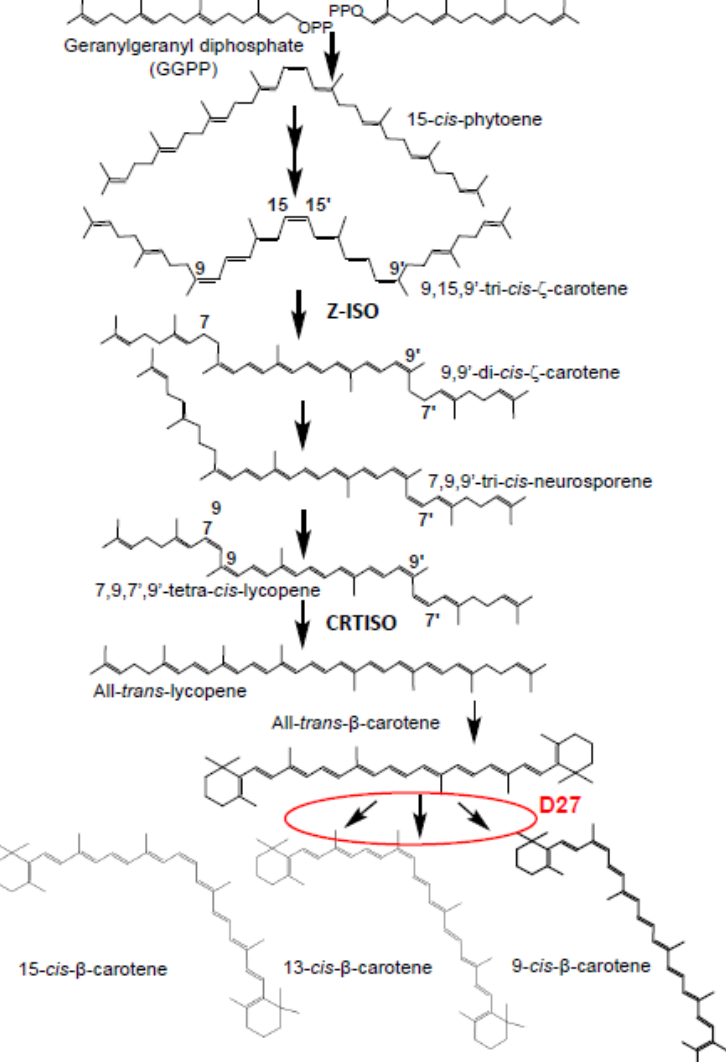
Figure 1. Carotenoid biosynthetic pathway from geranylgeranyl diphosphate to β -carotene. The steps in which carotenoid isomerases are known to be involved are indicated by the name of the corresponding enzymes. The described isomerase activity of D27 over β -carotene is indicated in red.